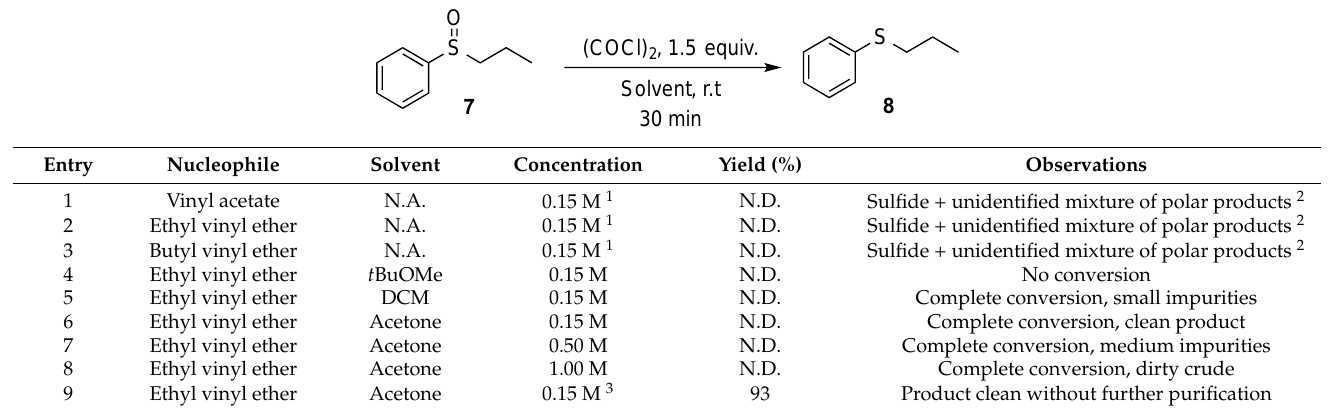
Table 1. Optimization results using 7 and oxalyl chloride (1.5 equiv.).